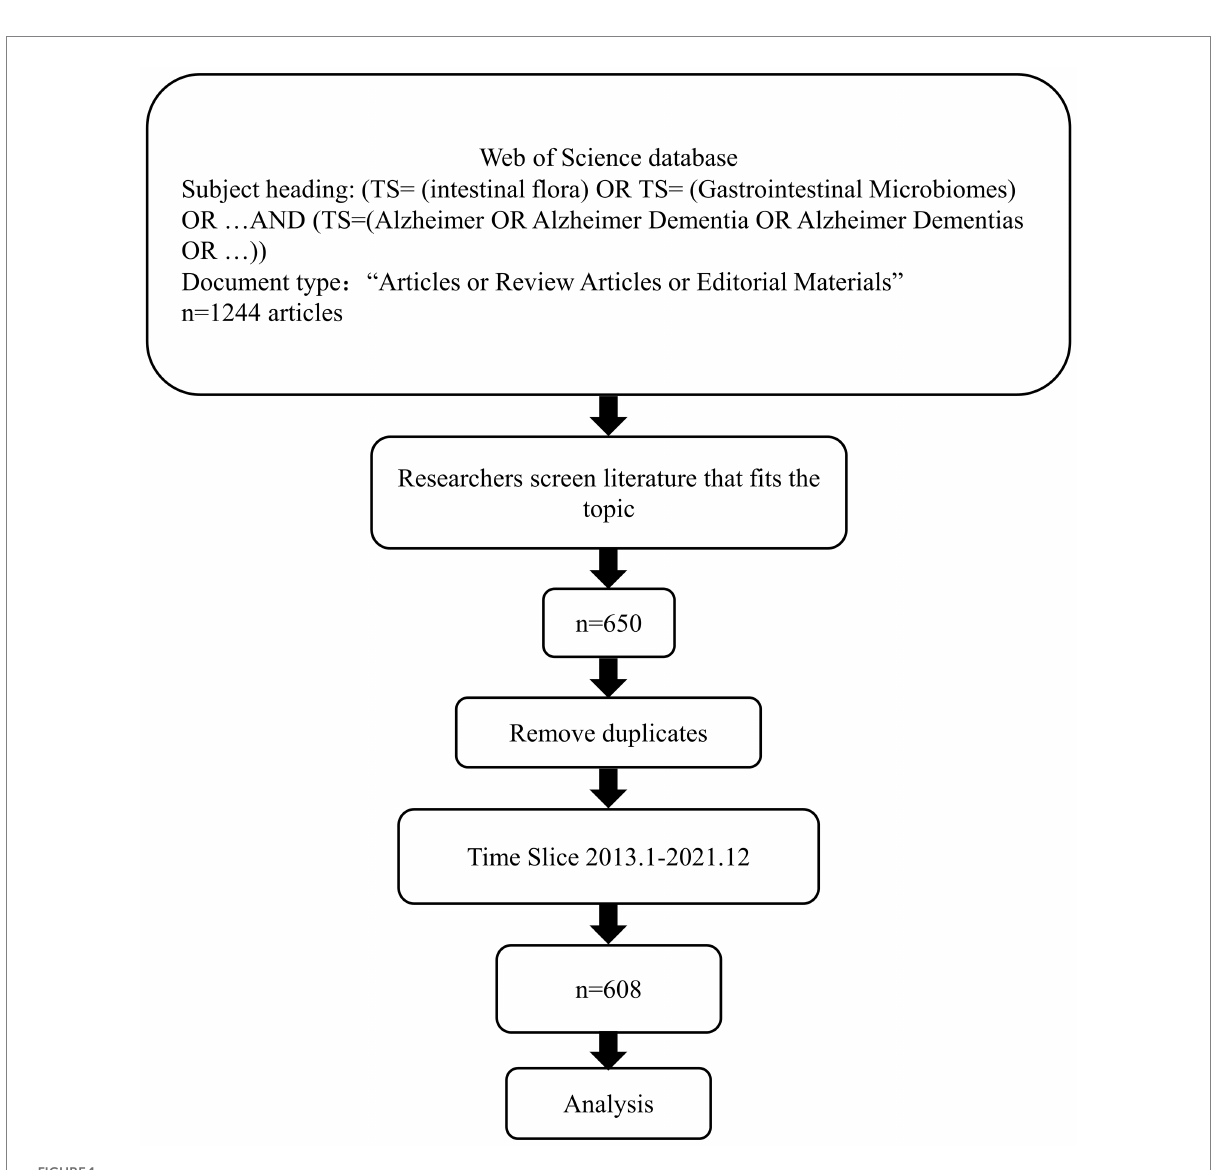
FIGURE 1 Search strategy in this